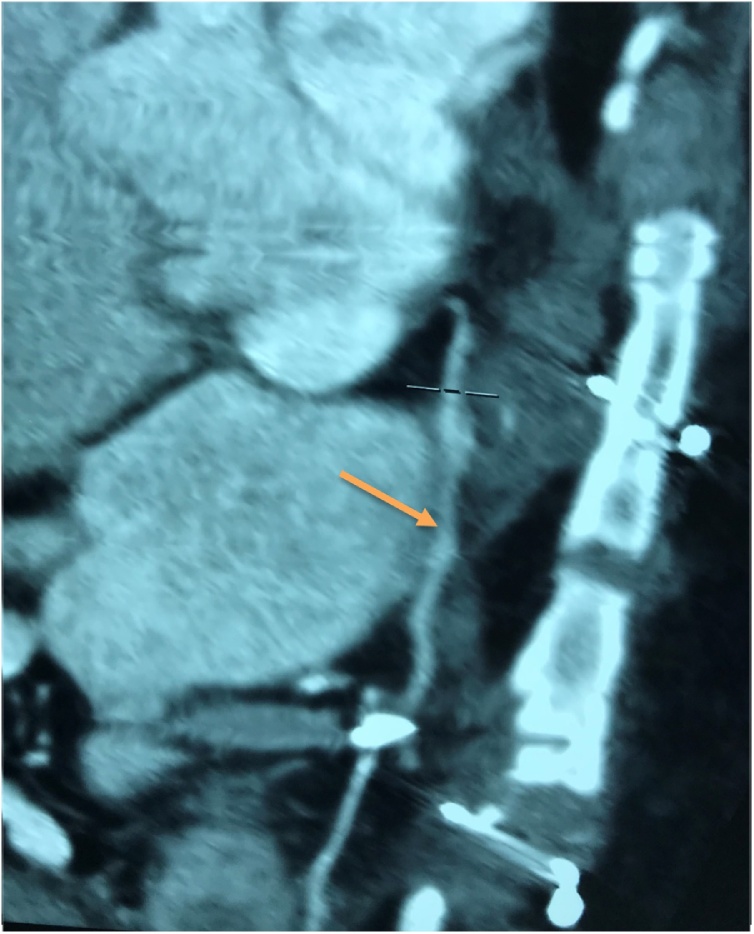
The postoperative enhanced CT of the chest was performed one-month post-CABG and the coronary reconstructions by GSV revealed patent (orange arrow).